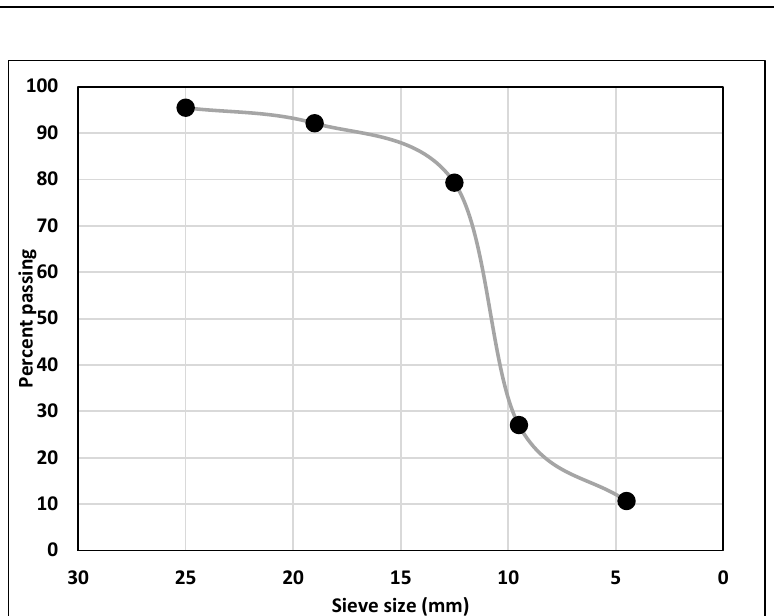
Figure 1. Gradation of coarse aggregate.